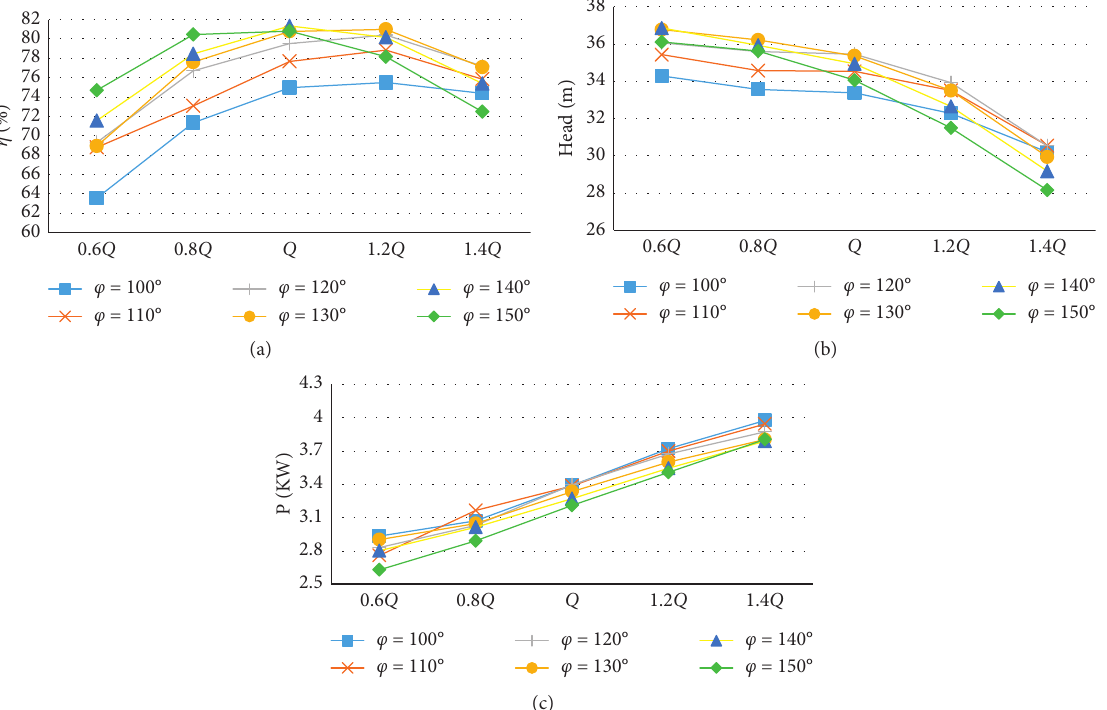
Figure 18: External characteristic curve of the plastic centrifugal pump under different wrap